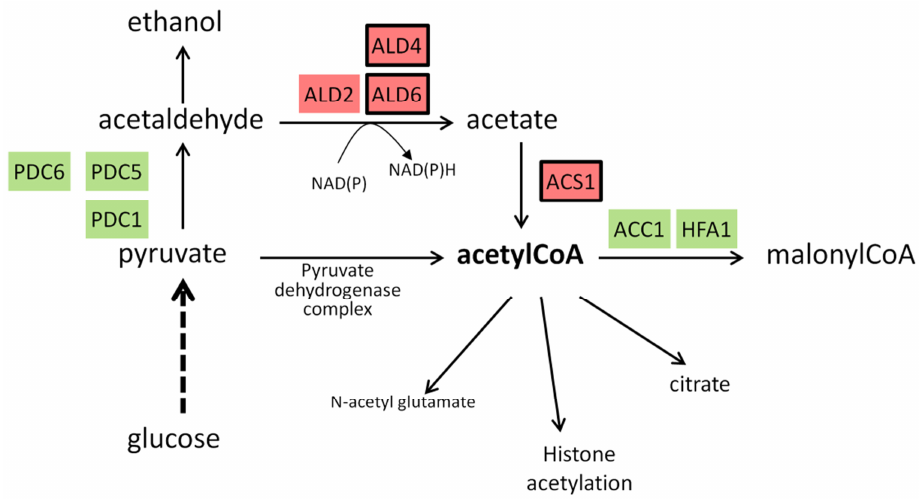
Figure 2, the expression profile of diverse genes metaboli-